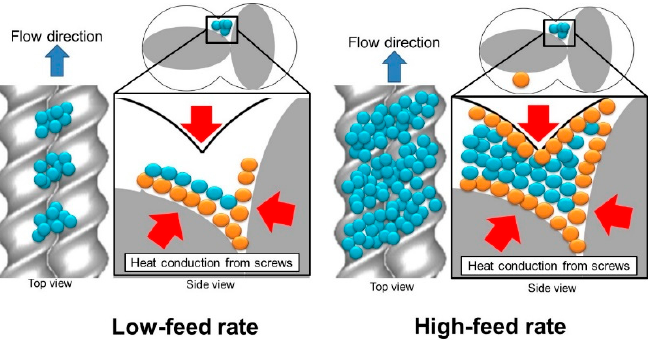
Figure 8. Comparison of the accumulation of pellets in the valley of twin screws in the full-flight screw zone between low feed and high feed rates at a constant screw rotation.